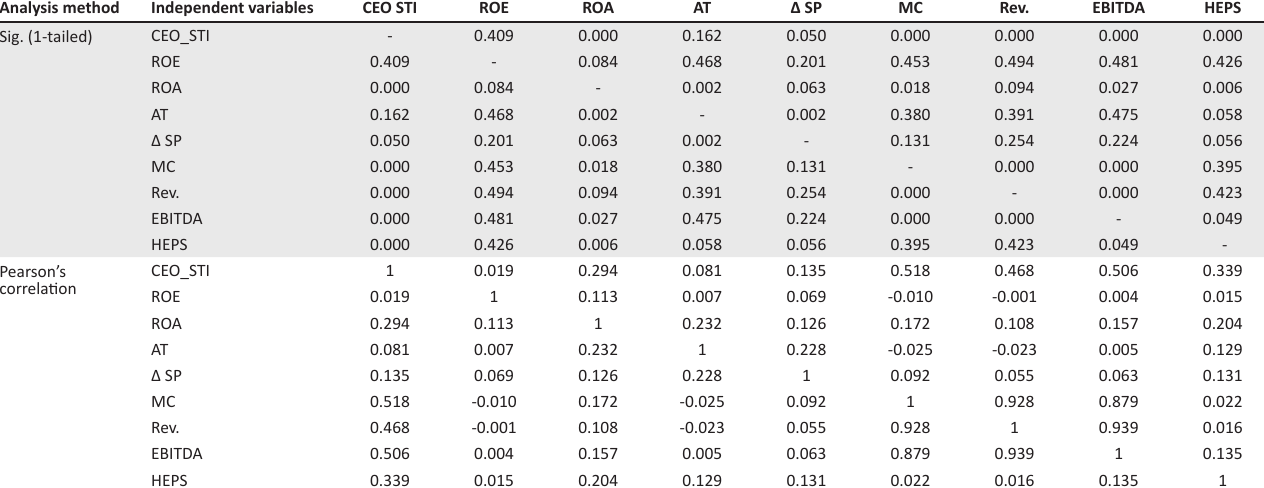
TABLE 3: Short-term incentive and organisational performance correlation. Analysis method Independent variables